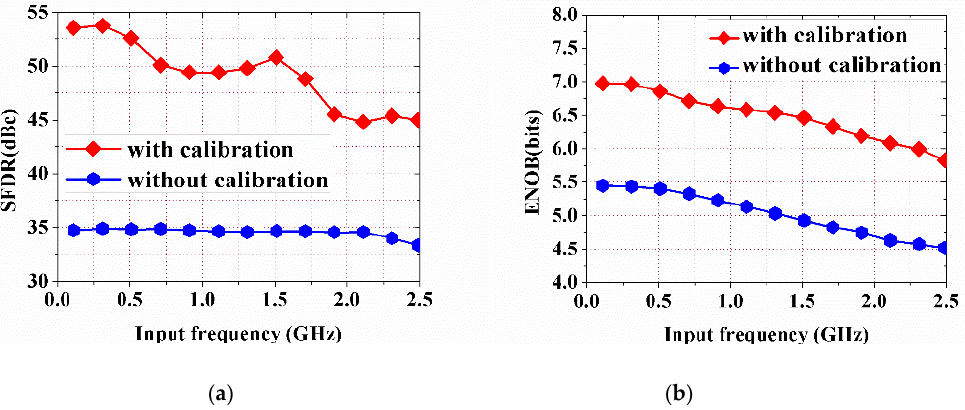
Figure 15. ( a ) Spurious free dynamic range (SFDR) versus input frequency; ( b ) Effective number of bits (ENOB) versus input frequency.